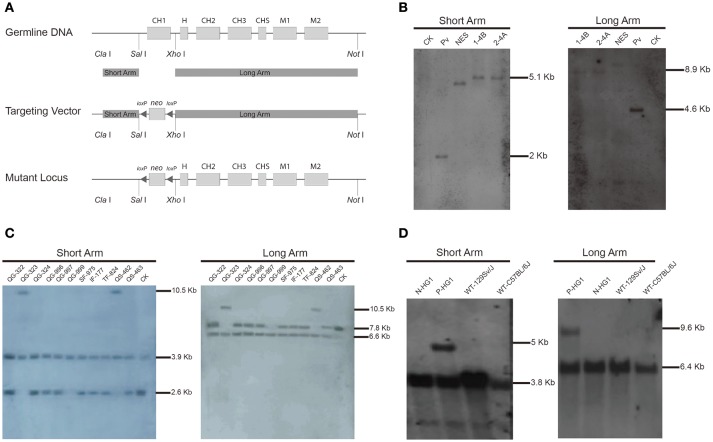
Construction of the targeting vector and generation of the γ1-CH1 deleted mice.(A) Targeting strategy for the genetic modification designed to delete the γ1 CH1 exon. (B) Identification of correctly targeted ES cell clones by Southern blotting. Southern blotting was performed using the DIG-labeled probe for the neo gene. Genomic DNA was digested with Xho I + EcoR I and Sal I + Hind III to detect the short (5.05 kb) and long (8.94 kb) homologous arms, respectively. CK: 129/SvJ wild type mice; Pv: pPNIII vector digested with EcoR I; NES: negative ES cell clone 1–2A. (C) Identification of homozygous knockout mice by Southern blotting. Genomic DNA was digested with Sph I + Dra I to detect the homologous arms. The positive mice, QG-999, exhibited a 6.63 kb band for the long homologous arm and a 3.91 kb band for the short homologous arm. (D) Identification of HG1 mice with the neo gene deleted by Southern blotting. Genomic DNA was digested with Sph I + Nco I and Sph I + EcoN I to detect the short and long homologous arms, respectively. Positive mice exhibited a 5.06 kb band for the short homologous arm and a 9.44 kb band for the long homologous arm. P-mouse, positive mouse; N-mouse, negative mouse.